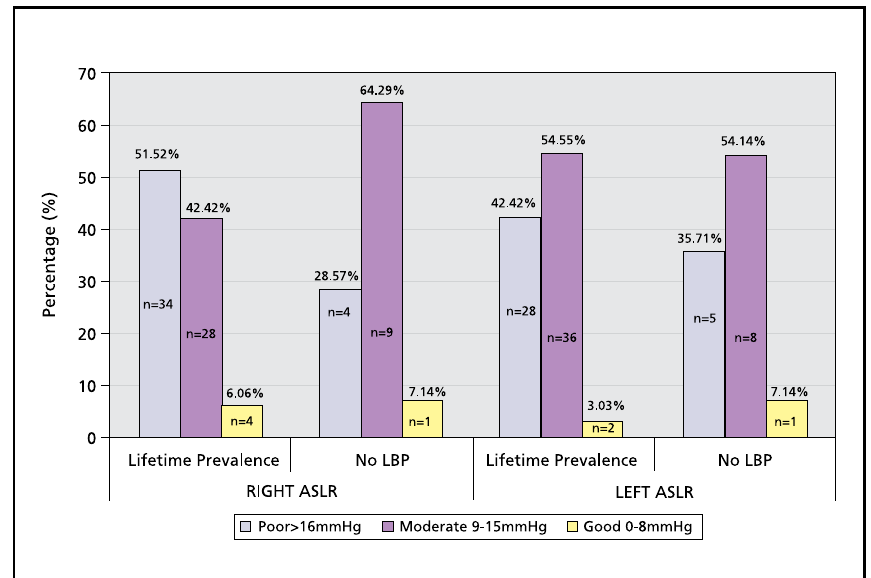
Figure 4: Pressure change at Psis on side of aslR test